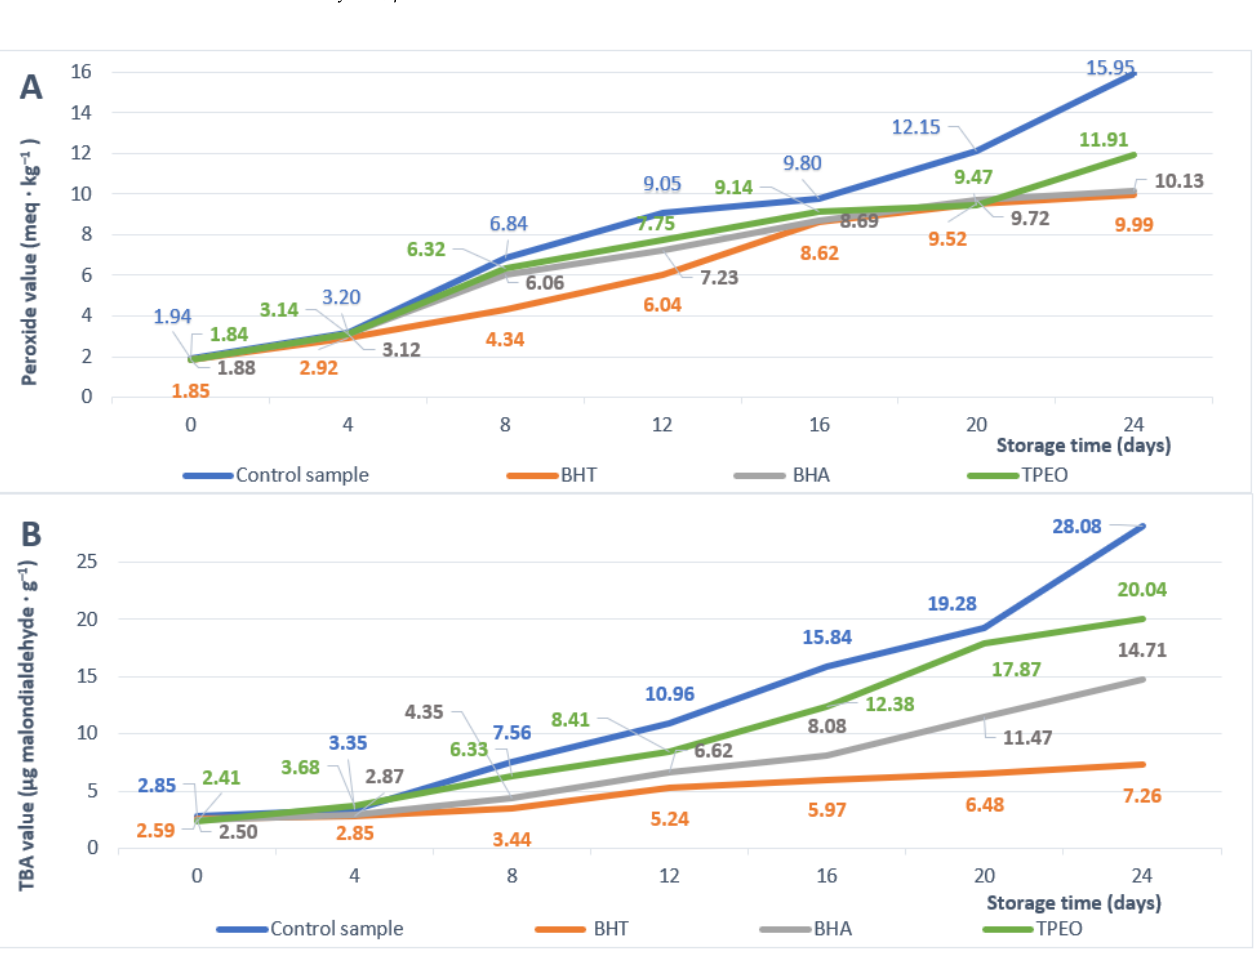
Figure 1. The influence of BHT, BHA, and TPEO on PVs ( A ) and TBA values ( B ) of sunflower oil samples during 24 days of storage. Values are expressed as means ± SD (n = 9).